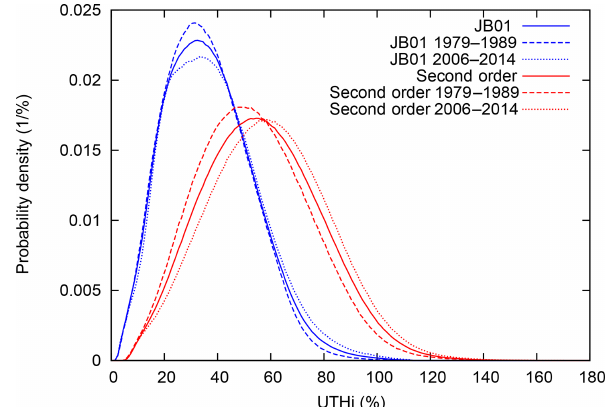
Figure 9. Time series of monthly fractional threshold exceedances for UTHi exceeding 70%, 80%, 90% and 100% (various grey scales) in the Northern Hemisphere between 30 and 70 ◦ N and from July 1979 to December 2014.